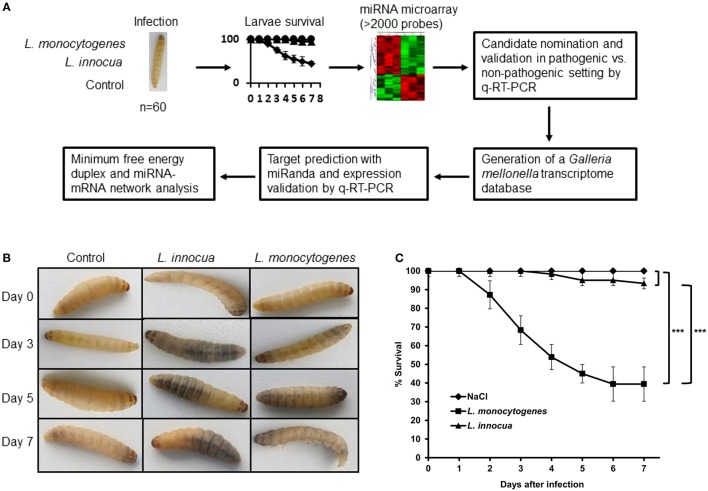
(A) Depicts the workflow taken in this study to comprehensively examine the miRNA response following infection of G. mellonella with pathogenic and non-pathogenic Gram-positive bacteria. (B) Macroscopic changes of G. mellonella larvae of infected larvae over time highlight the reduced viability of larvae infected with pathogenic L. monocytogens. (C) Survival curves of larvae (n = 60) infected with L monocytogens, L. innocua or control confirms macroscopic observations. This resulted in a median survival of 6 days post infection in in the L. monocytogens group (p ≤ 0.0001), while L. inncoua did not induce significant mortality (p > 0.05).